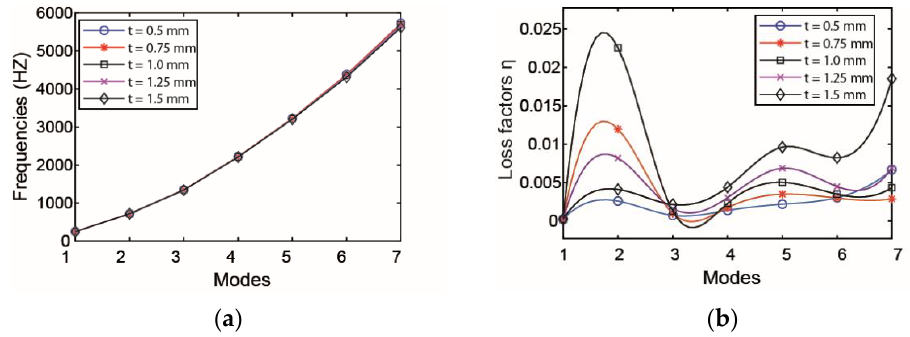
Figure 5. Influence of thickness of viscoelastic layer on the ( a ) modal frequency and ( b ) loss factor.